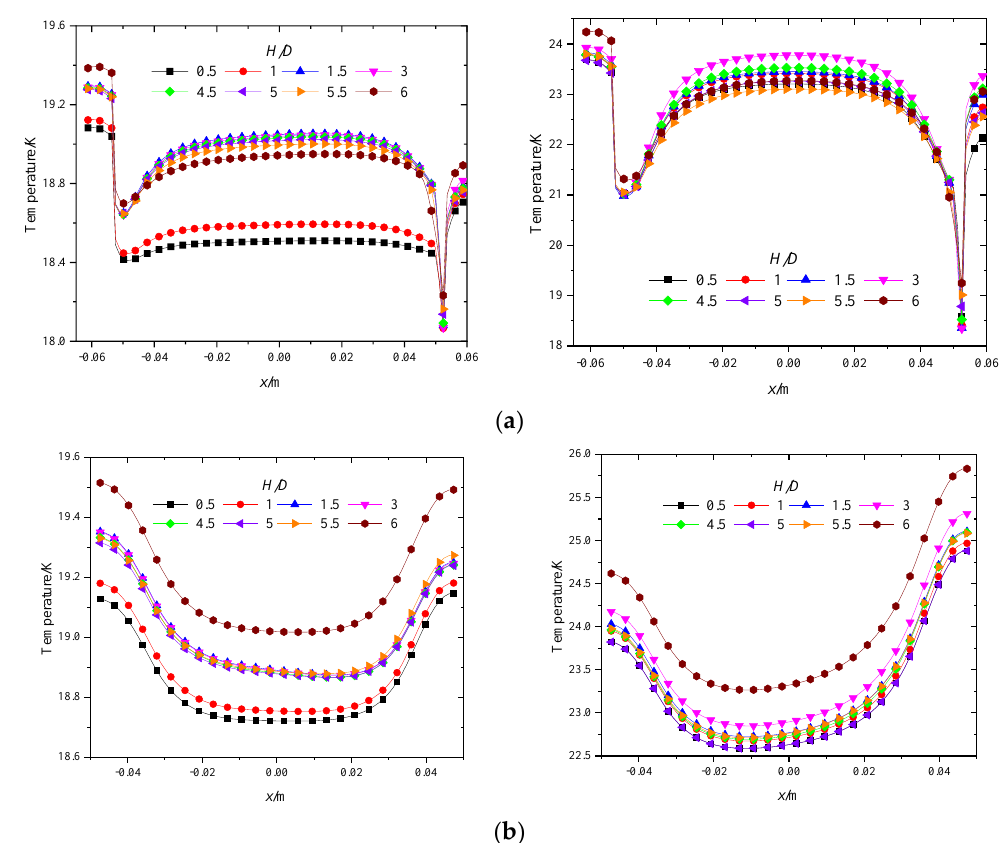
Figure 18. The variation of the temperature with x at specific y section (Left:100 kW; Right:500 kW): ( a ) y = −30 mm ; ( b ) y = −75 mm.